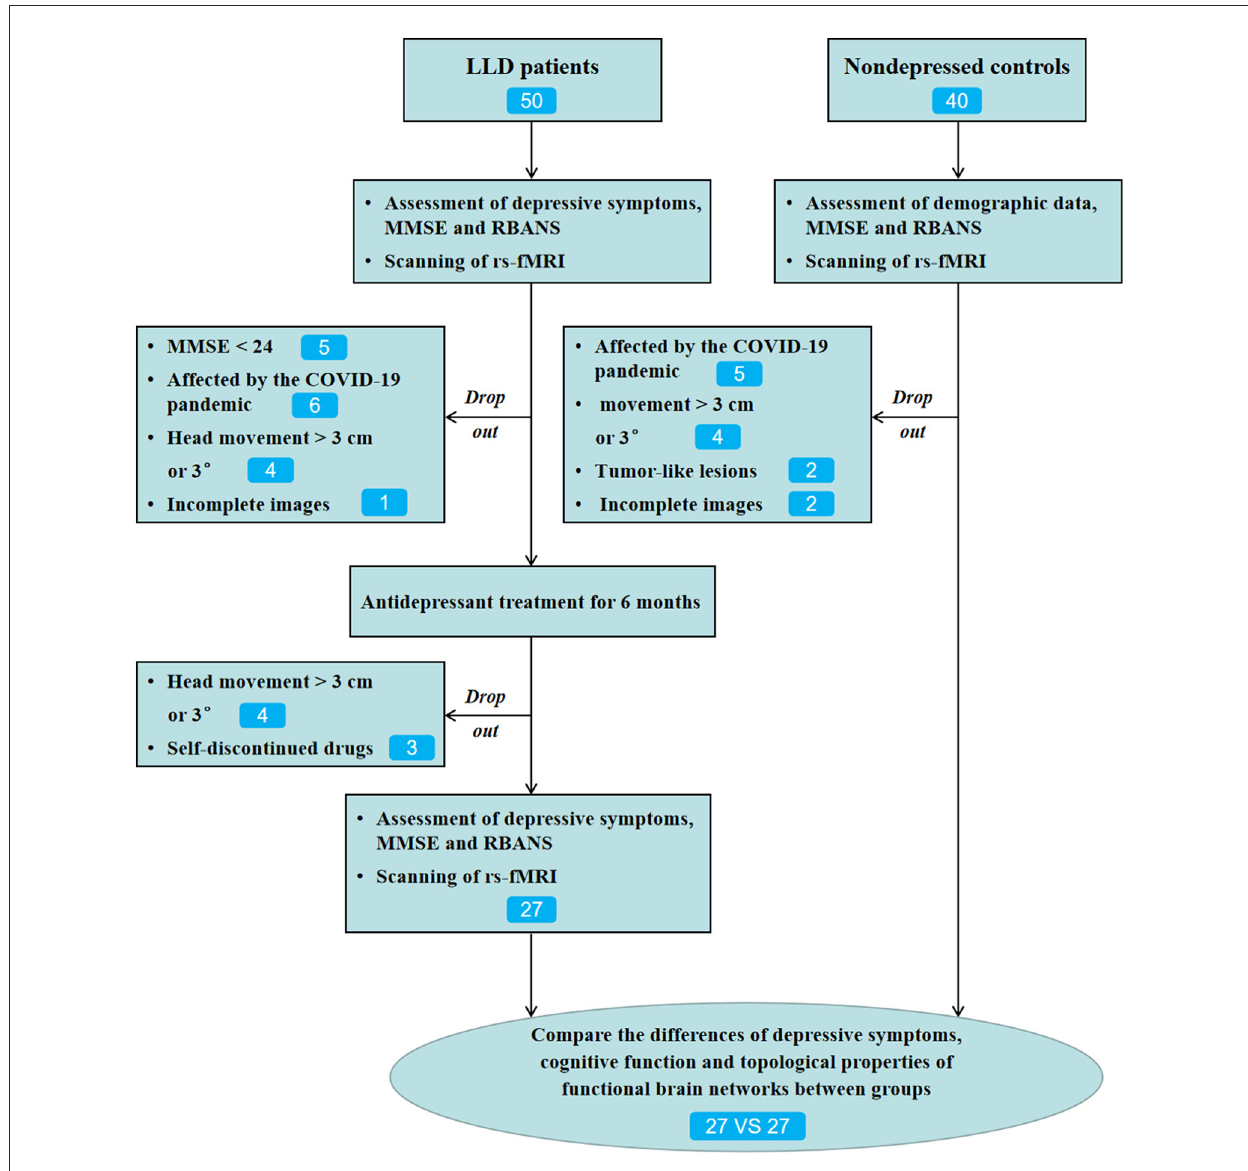
FIGURE1 Flow diagram of this